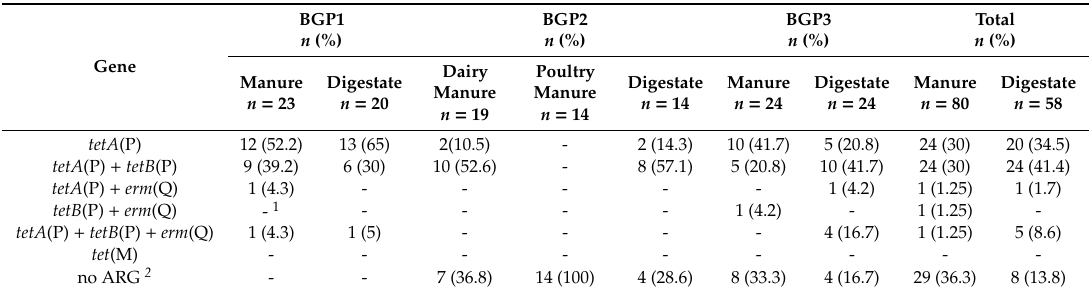
Table 4. Detection of antimicrobial resistance genes ( tetA (P), tetB (P), tet (M), and erm (Q) genes) of isolates in manure and digestate in three biogas